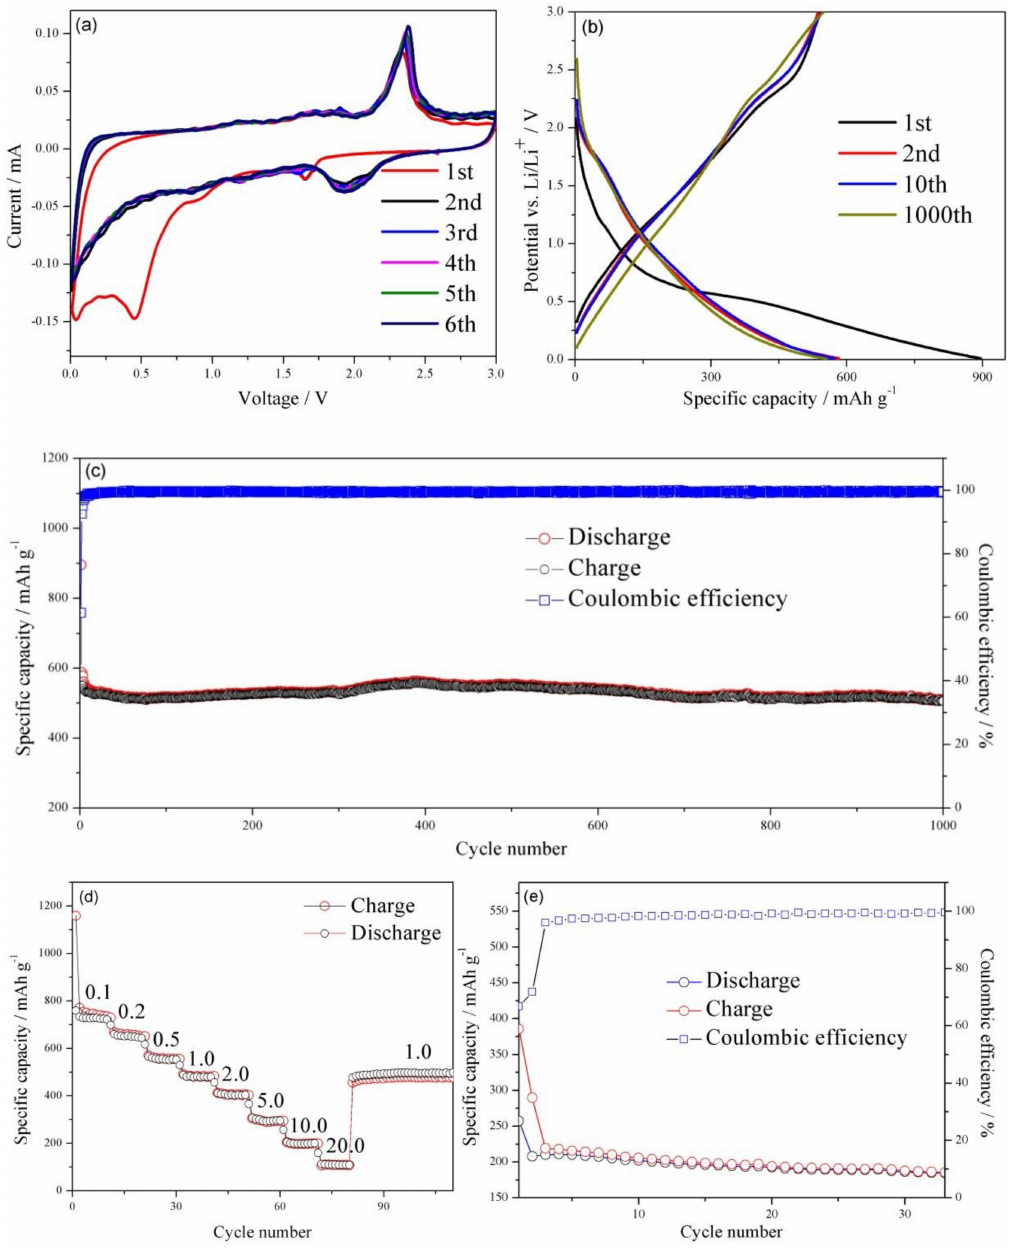
Figure 4. ( a ) CV curves of the WS 2 /rGO composite at 0.01 mV · s − 1 in the 0.01 to 3.0 V voltage window. ( b ) Charge/discharge voltage profiles of WS 2 /rGO at 1.0 A · g − 1 . ( c ) The cycle stabilities of the WS 2 /rGO at 1.0 A · g − 1 . ( d ) The rate capacities of WS 2 /rGO at 0.1, 0.2, 0.5, 1.0, 2.0, 5.0, 10.0 and 20.0 A · g − 1 . ( e ) The cycle stabilities of the bare WS 2 at 1.0 A · g − 1